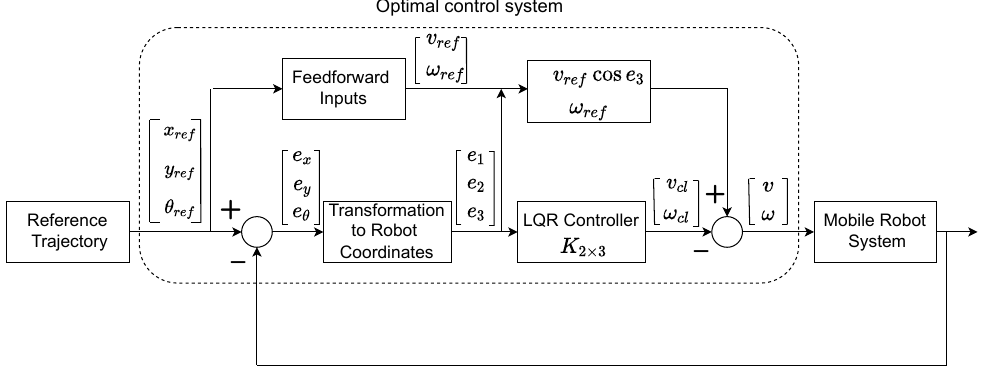
Figure 2. Mobile robot